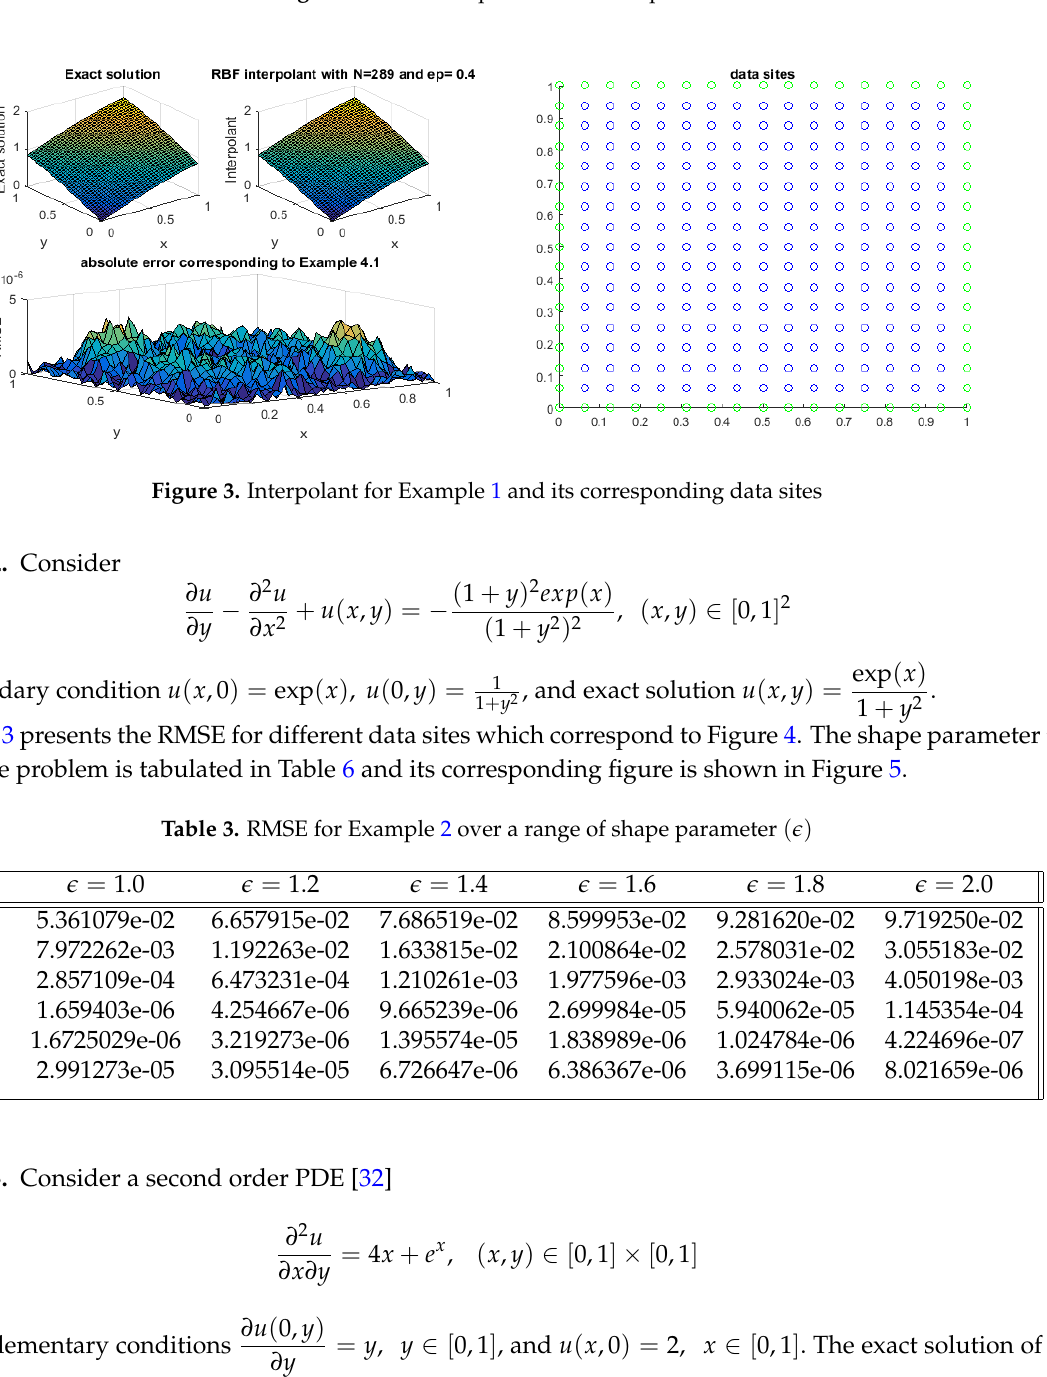
Figure 2. Error Comparison for Example 1